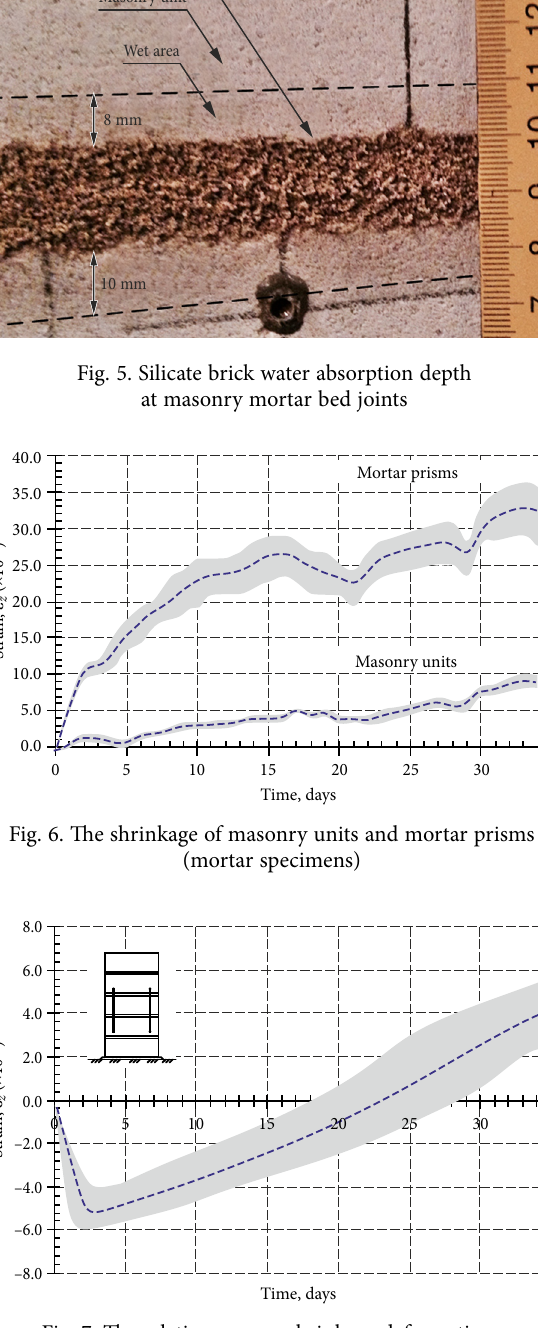
Fig. 7. The relative average shrinkage deformations of masonry